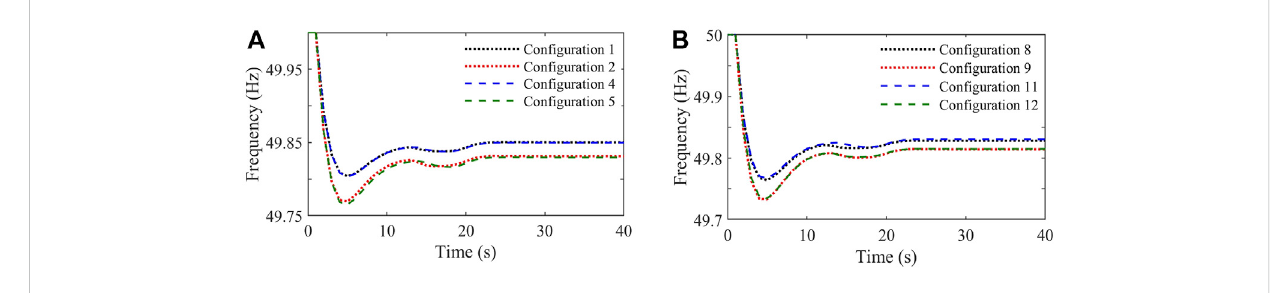
FIGURE 5 System frequency curves under (A) scenario 1 and (B) scenario 2.